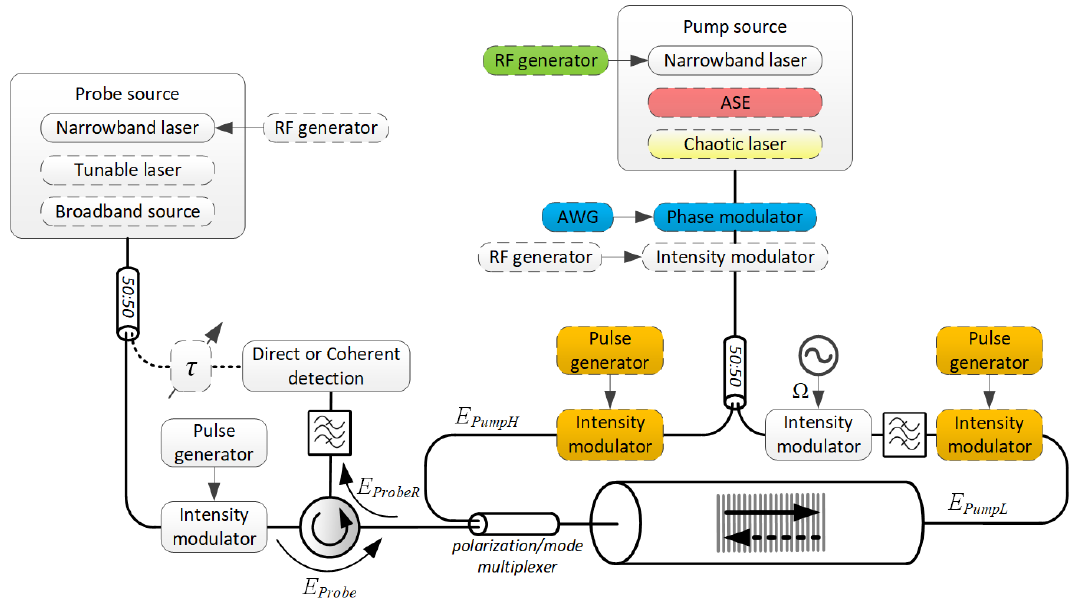
Figure 2. A schematic diagram depicting a complete BDG setup with emphasis on the alternatives for BDG generation . Frequently used components are marked with solid lines, while the dashed lines mark the more exotic ones. Colors highlight the components of different BDG generation techniques.